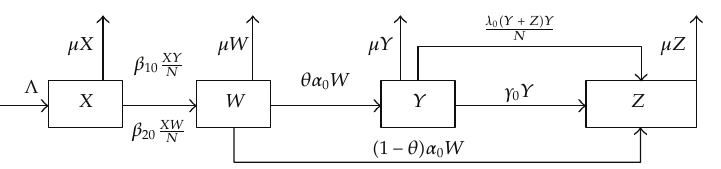
Figure 1: The basic scheme of population dynamics models for the spread of